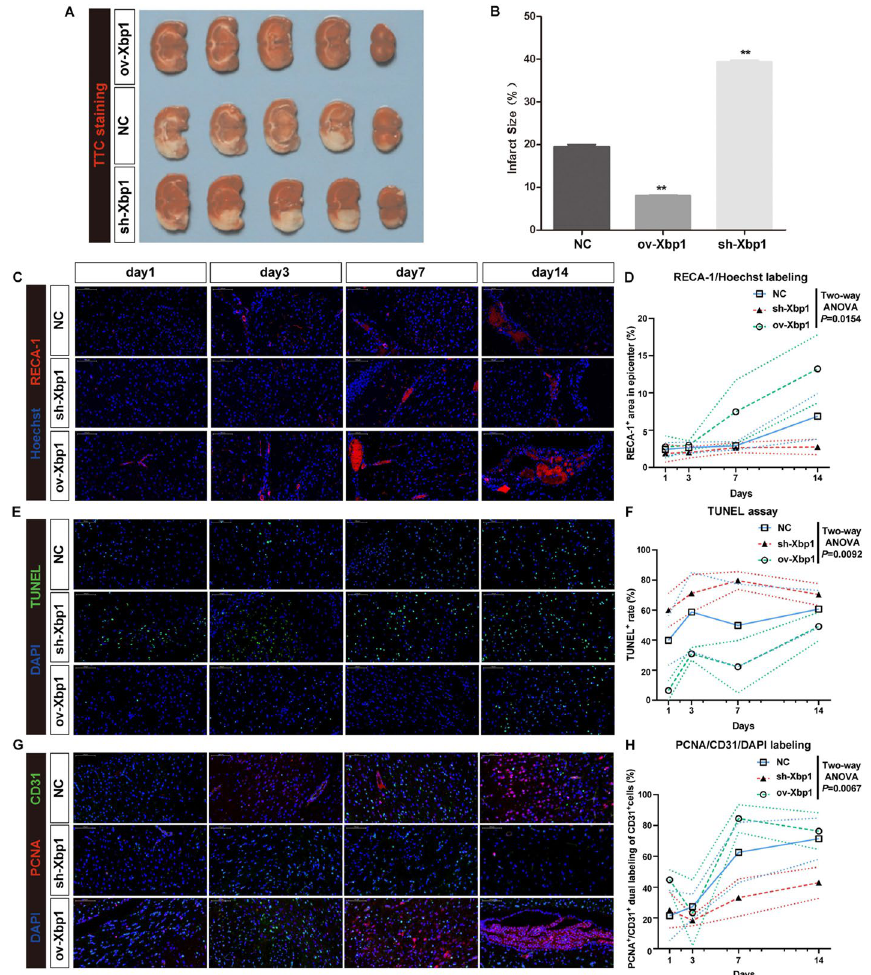
Fig. 5 In vivo assays confirming the roles of Xbp1 in improving survival, attenuating apoptosis, and promoting angiogenesis in BMECs. A Representative images showing the infarct size of ischemic brain dyed with TTC staining. Regions without staining were considered infarct regions. TTC 2,3,5-triphenyl tetrazolium chloride. B Bar plot summarizing the infarct size of ischemic brain under different Xbp1 interventions. Results are presented as mean SD ( n 3 in each group). One-way ANOVA followed by post hoc test. * P < 0.05, ± = ** P < 0.01 compared to the control. C Representative images showing the survival of endothelial cells by RECA-1 (red) /Hoechst (blue) dual labeling of the brain slices at days 1, 3, 7, and 14 under ov-Xbp1, sh-Xbp1, and NC conditions. Scale bar, 100 μm. D Statistics showing the percentage of RECA-1 + cell area out of each visual fields at days 1, 3, 7, and 14 under ov-Xbp1, sh-Xbp1, and NC conditions. Results are presented as mean SD ( n 3 in each groups). Two-way ANOVA. P < 0.05 was considered statistically significant. RECA-1 ± = rat endothelial cell antigen-1, NC normal control. E Representative images showing apoptosis in the brain by TUNEL (green)/DAPI (blue) dual labeling of the brain slices at days 1, 3, 7, and 14 under ov-Xbp1, sh-Xbp1, and NC conditions. Scale bar, 100 μm. F Statistics showing the percentage of the number of TUNEL + cells out of DAPI + cells at days 1, 3, 7, and 14 under ov-Xbp1, sh-Xbp1, and NC conditions. Results are presented as mean SD ( n 3 in each group). Two-way ANOVA. P < 0.05 was considered statistically significant. TUNEL ± = terminal deoxynucleotidyl transferase (TdT) dUTP nick-end labeling, DAPI 4 ′ ,6-diamidino-2-phenylindole. G Representative images showing the proliferating endothelial cells by CD31 (green)/PCNA (red)/DAPI (blue) tri-labeling of the brain slices at days 1, 3, 7, and 14 under ov-Xbp1, sh-Xbp1, and NC conditions. Scale bar, 100 μm. H Statistics showing the percentage of the number of PCNA + /CD31 + dual labeling cells out of CD31 + cells at days 1, 3, 7, and 14 under ov-Xbp1, sh-Xbp1, and NC conditions. Results are presented as mean SD ( n 3 in each group). Two-way ANOVA. P < 0.05 was considered statistically significant. PCNA ± = proliferating cell nuclear antigen, DAPI 4 ′